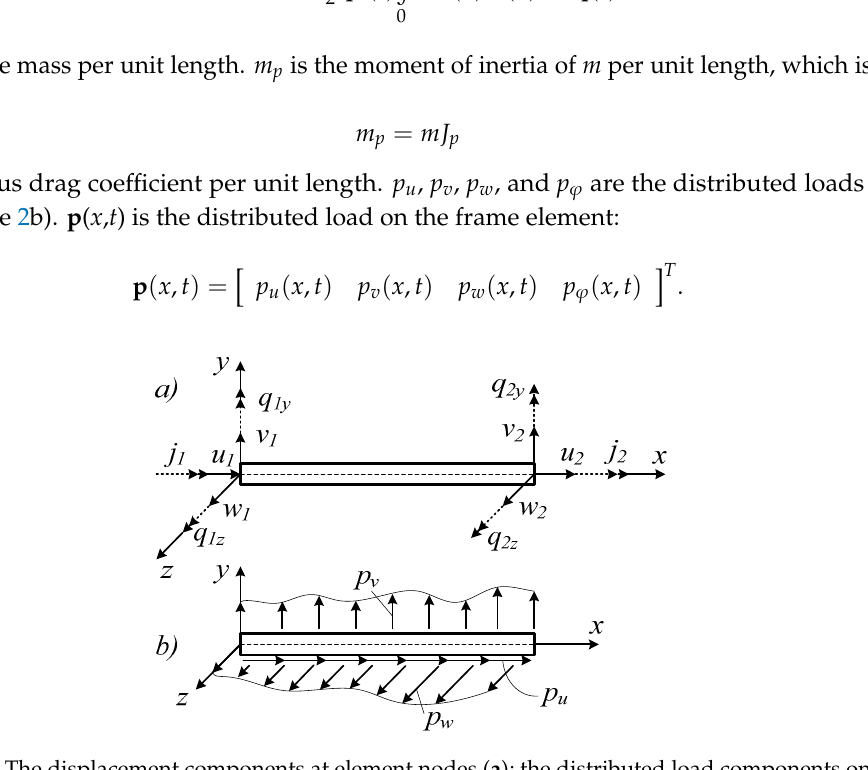
Figure 2. The displacement components at element nodes ( a ); the distributed load components on the frame element ( b